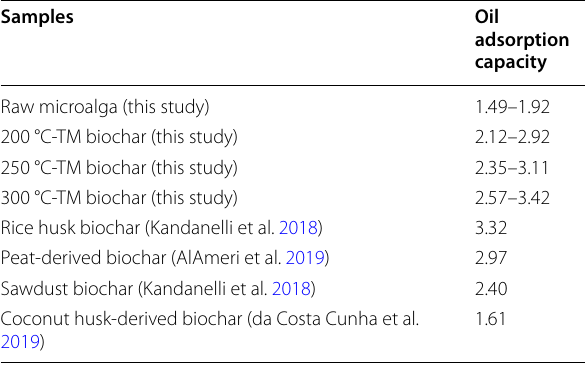
Table 2 Comparison of oil adsorption capacities (g g ‑1 ) in this study and previous